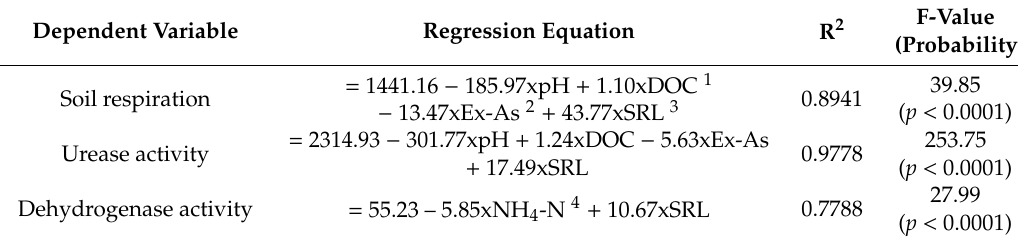
Table 3. Contribution of various experimental results on soil biological characteristics using stepwise multiple regression